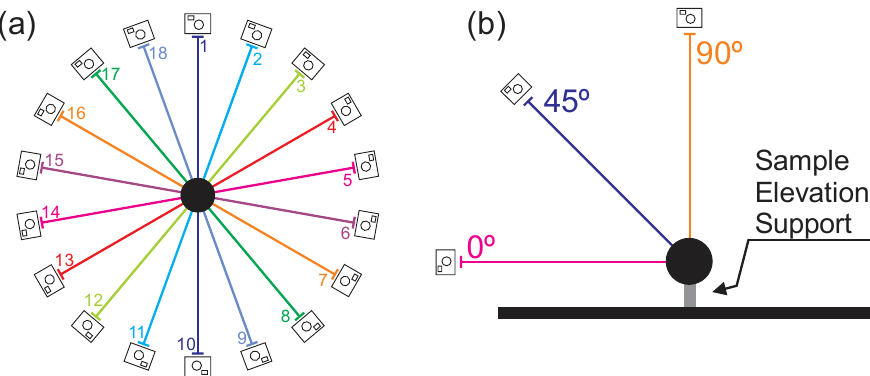
Figure 7. ( a ) Perimetric horizontal distribution of images with 75% lateral overlap. The 18 images represented in the figure allow the proper reconstruction of the object of interest. ( b ) Vertical distribution of images. The 0° and 45° elevation planes have 18 images for reconstruction and the 90° plane might have 3 to 5 images.